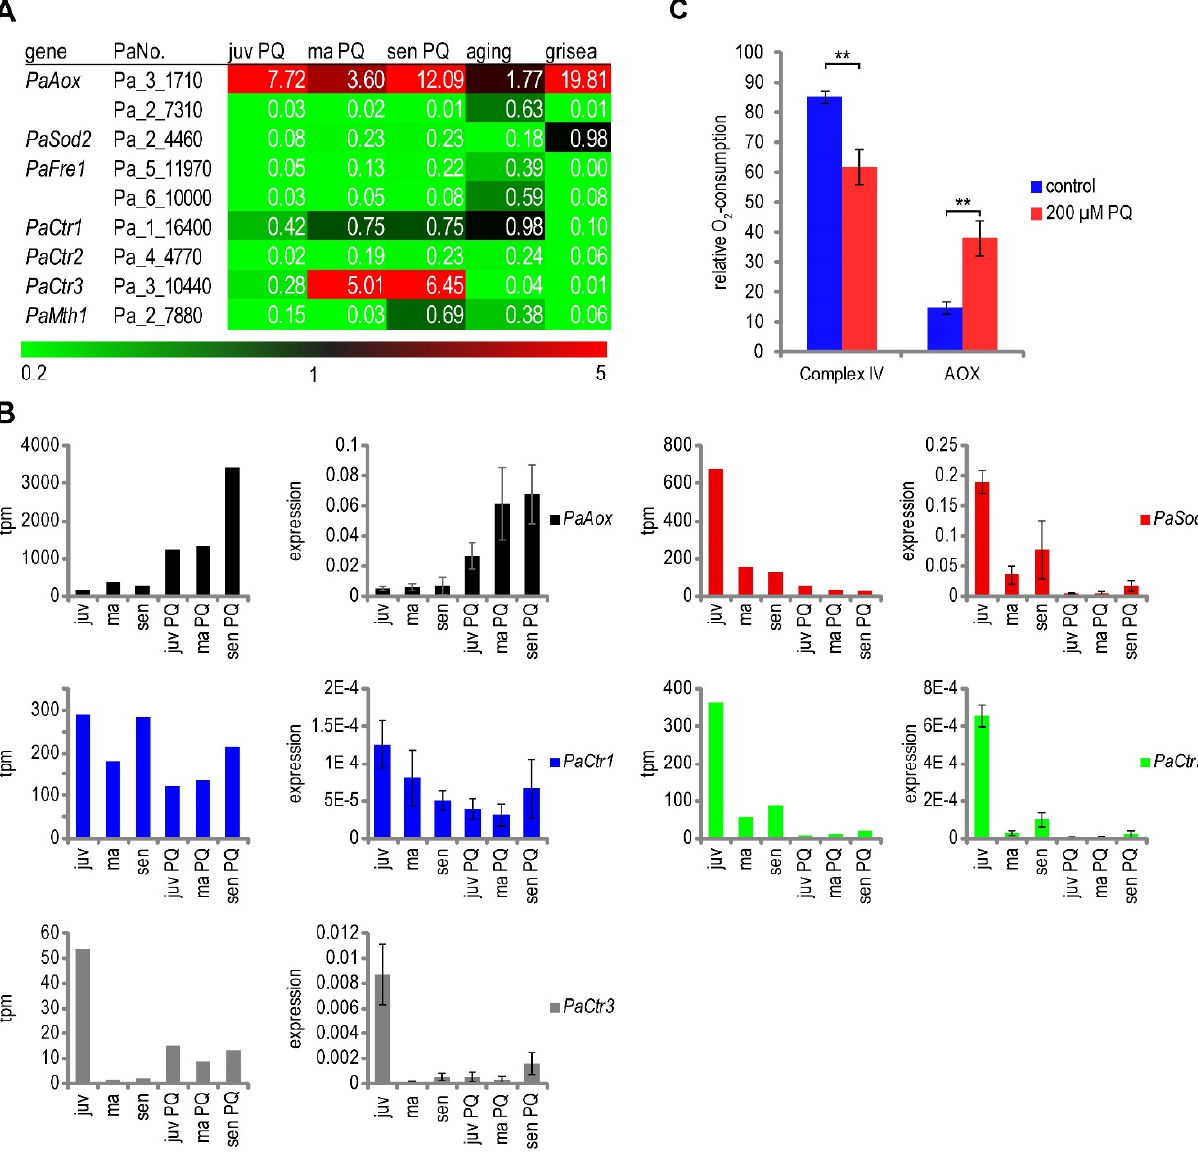
OPEN ACCESS | www.microbialcell.com 234 Microbial Cell | July 2014 | Vol. 1 No. 7